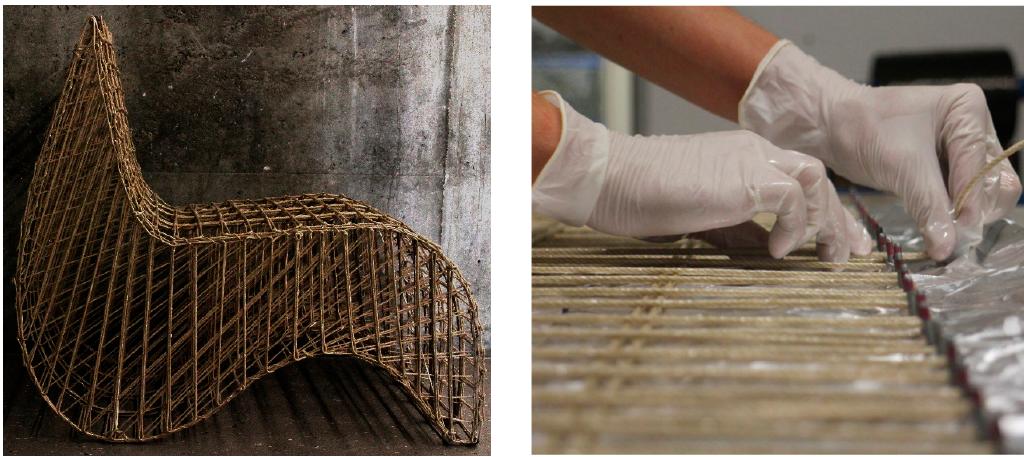
Figure 8. The hemp chair during production, with an emphasis on the winding process applied for the lignocellulosic endless fibres that are pre-soaked in the resin bath. Photo credit: Sachin and Kauffmann, BioMat-ITKE/University of